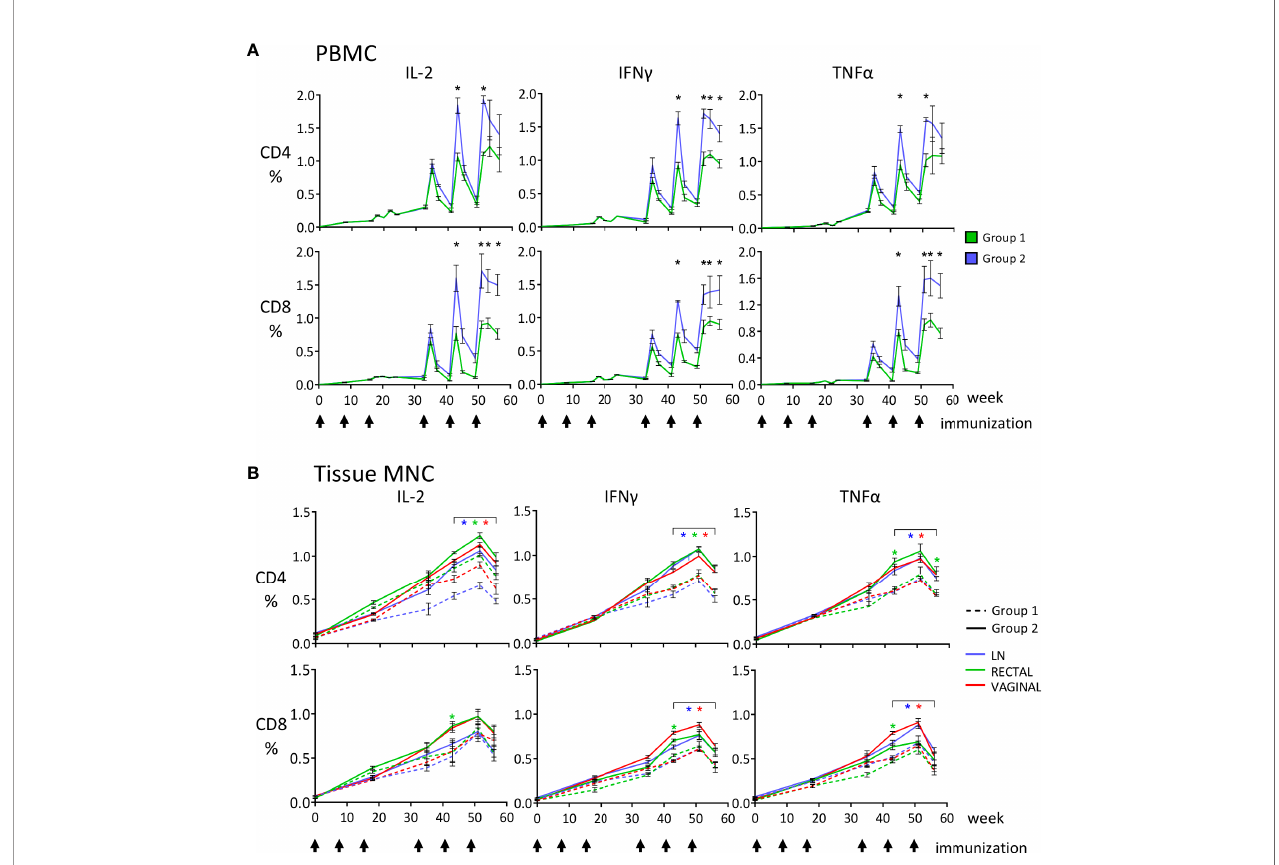
FIGURE 3 | Quantitative analysis of the anti-SHIV cell-mediated responses measured during the immunization phase, reported as percentages of CD4+ and CD8+ T cells producing IFN g , TNF- a and IL-2, detected by ICS and fl ow cytometric analysis upon stimulation with SIV Gag or HIV Env peptide pools. (A) PBMC, asterisks indicate that T-cell percentages (Gag + Env) at the indicated time points are signi fi cantly higher for Group 2 (SHIV BG505 -DNA+SHIV BG505 -OPV, blue) compared to Group 1 (SHIV BG505 -DNA+ rMVA-SHIV-BG505, green); (B) LN, rectal and vaginal MNC; the graphs show the total SHIV-speci fi c T-cell responses (Gag + Env) for the two vaccinated groups, Group 1 (dashed line) and Group 2 (solid line). Color refer to the source of samples examined (LN, vaginal or rectal). The color of the asterisks used in panel (B) to report statistical signi fi cance matches the color used for the samples in question. Asterisks under brackets indicate that values from week 43 to week 56 are all signi fi cantly higher for the speci fi c tissue when Group 2 is compared to Group 1 (p value range: 0.0001-0.039). Between groups comparisons reported in panels (A, B) were carried out by two-tailed, t test or Mann-Whitney U test when the value distribution was